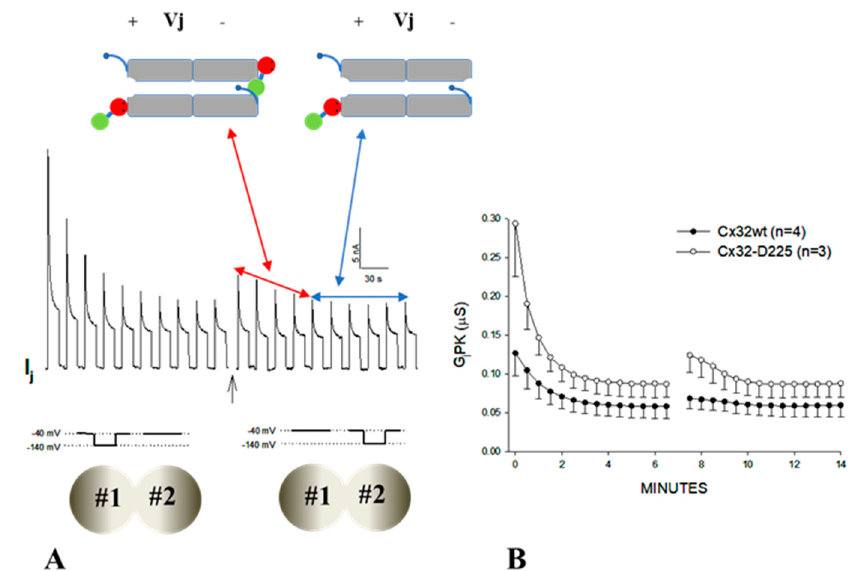
Figure 12. Effect of Vj polarity-reversal on junctional conductance (Gj) in oocyte pairs expressing either Cx32 subjected to Vj pulses of -100 mV. The Ij and GjPK records ( A and B , respectively) show that in the first few pulses of the second series peak Ij (IjPK; A , arrow) and consequentially GjPK ( B ) are substantially greater than that of the last pulse of the first series. This indicates that positive Vj is more effective in opening hemichannels than negative Vj in closing them. Significantly, this phenomenon is more pronounced with Cx32-D225 channels ( B ). From [82].